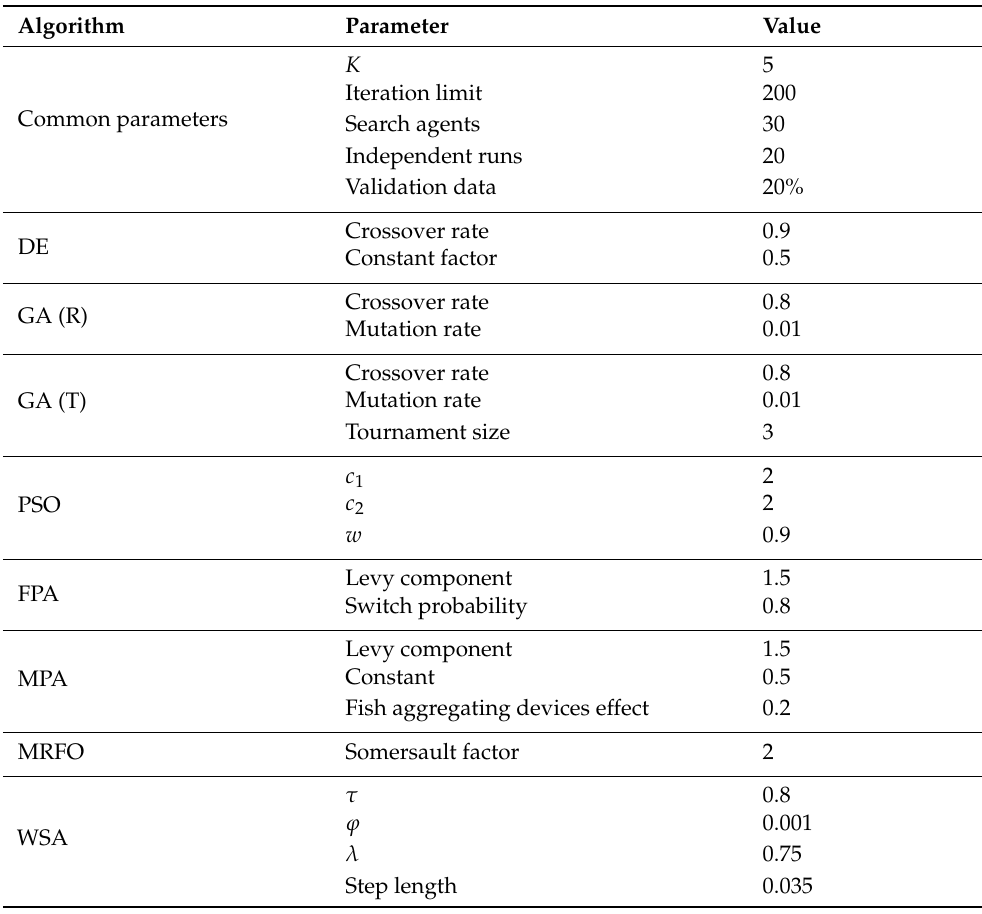
Table 2. Description of tuning parameters used in each